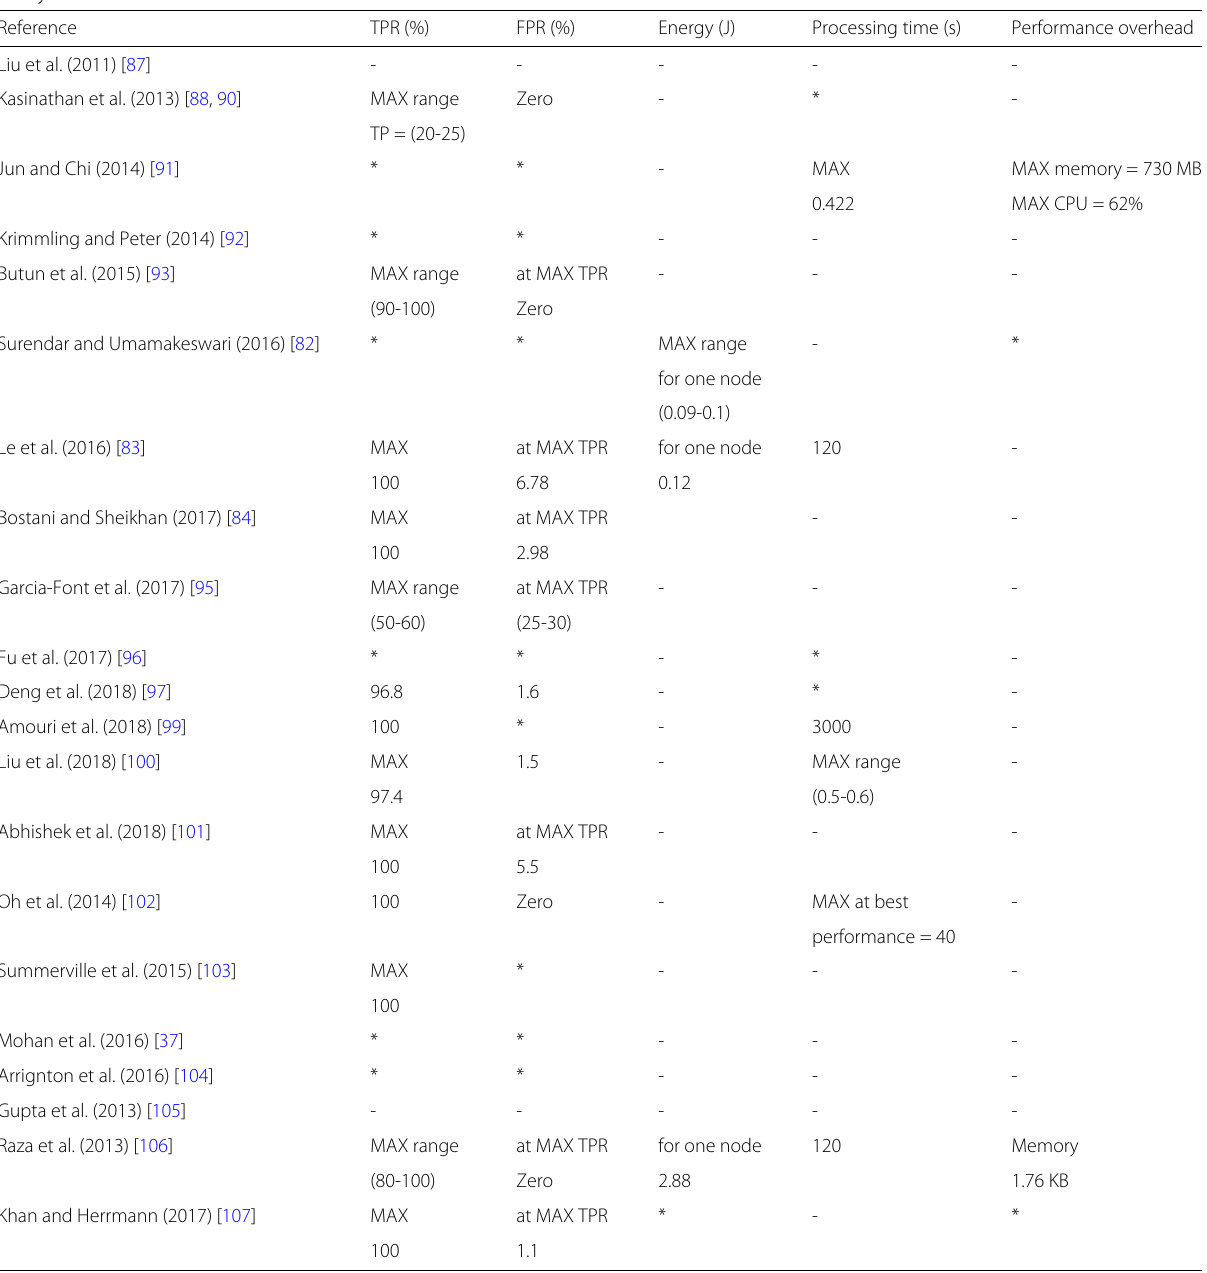
Table 4 A descriptive statistical analysis of the surveyed IDSs in terms of the important performance metrics affecting IDS suitability in IoT